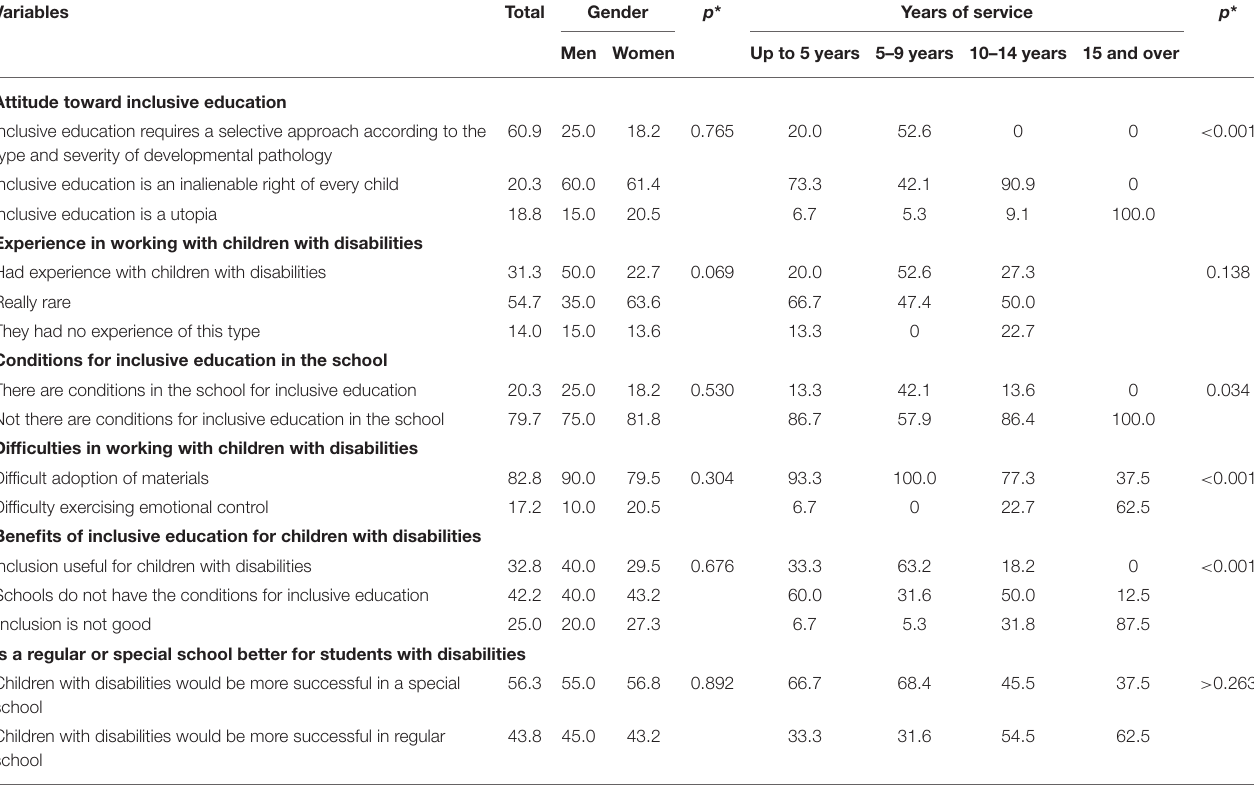
TABLE 1 | Sociodemografic characteristics of primary school teachers and attitudes toward inclusive education.